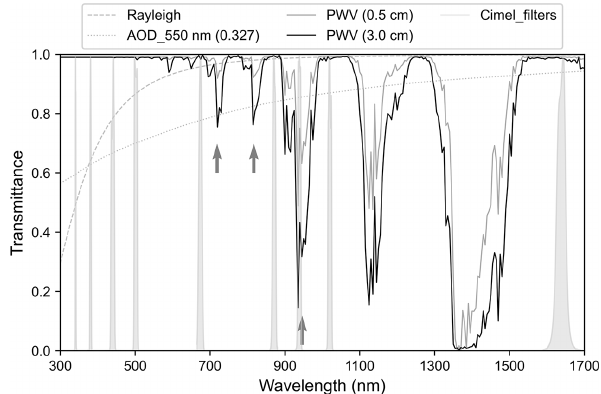
Figure 3. The spectrum response curves of the CE-318 sun pho- tometer’s filter wheels, and the transmittance of water vapor, aerosols, and Rayleigh scattering in the spectral range of 300– 1700nm, which are calculated by MODTRAN 4.3 at SZA = 0 ◦ , PWV = 0.5cm, PWV = 3.0cm, and AOD (550nm) = 0.327. The wavelengths pointed by the gray arrows represent WMO recom- mendations for PWV retrieval.